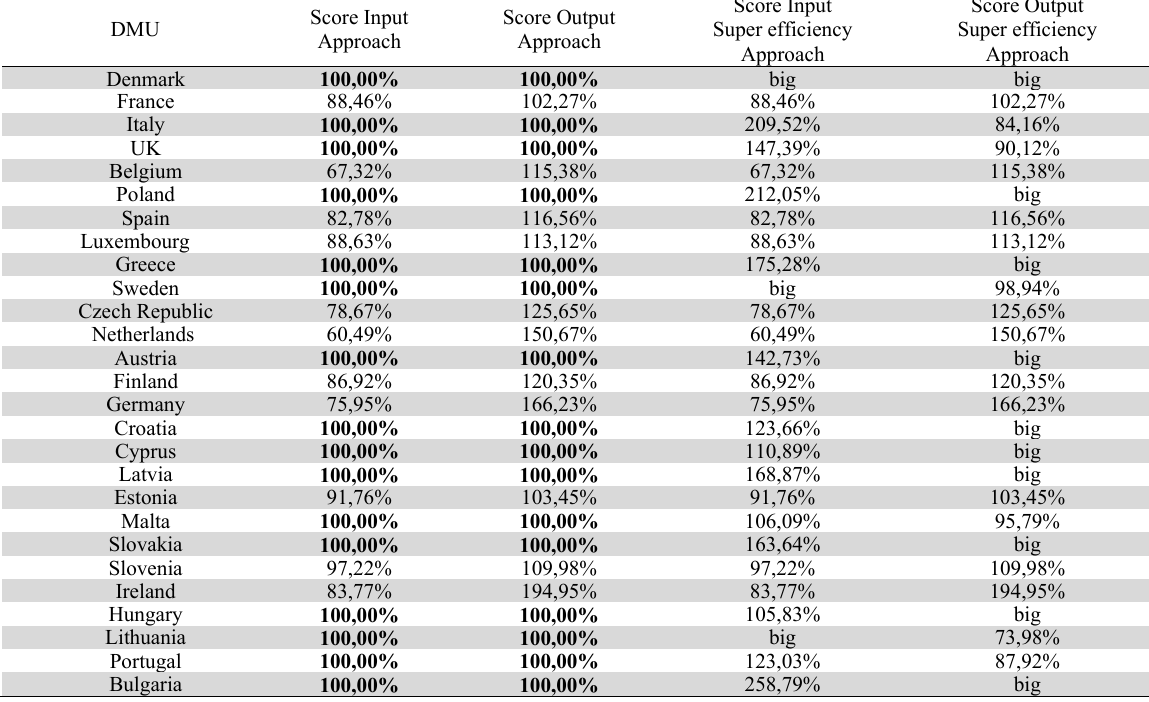
Efficiency Scores According to BCC